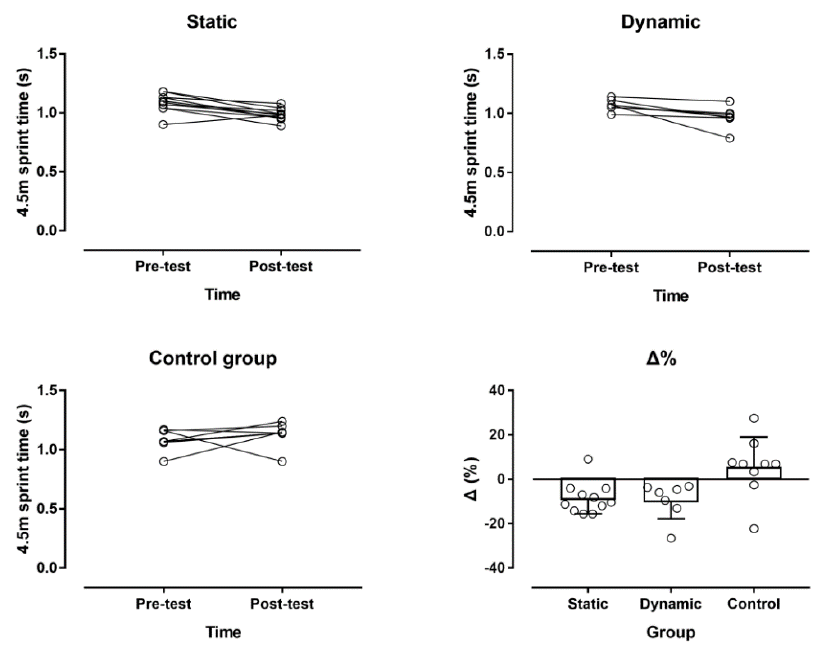
Figure4. Individualchangesinthe4.5msprinttimebyexperimentalgroupandpercentagechange( ∆ Figure 4. Individual changes in the 4.5 m sprint time by experimental group and percentage change (Δ%).